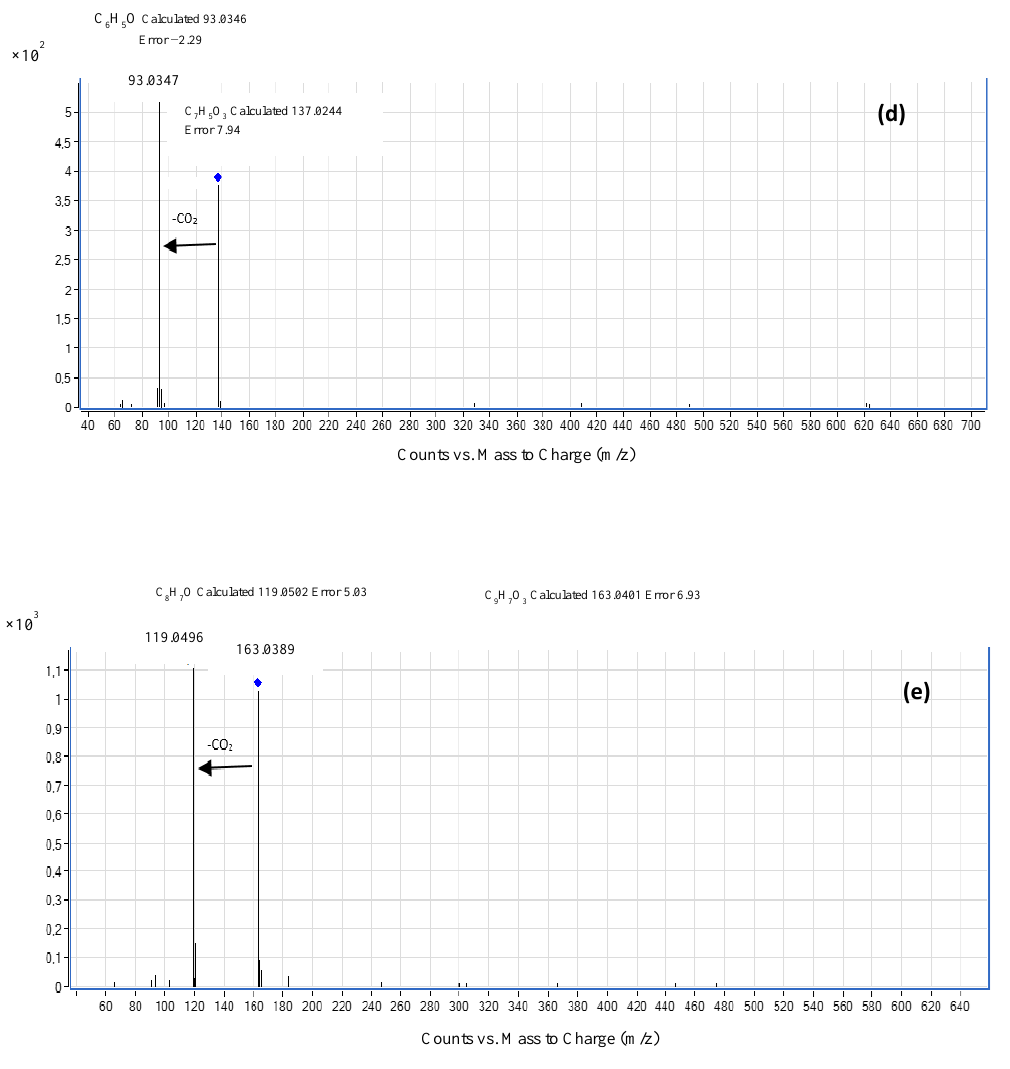
Figure 1. ESI ( − )-MS/MS spectra corresponding to: catechin ( a ); quercetin ( b ); gallic acid ( c ); 4-hydroxybenzoic acid ( d ); and p -coumaric acid ( e ). Table 2. Polyphenols identified by HPLC-MS in Caesalpinia decapetala (CD)